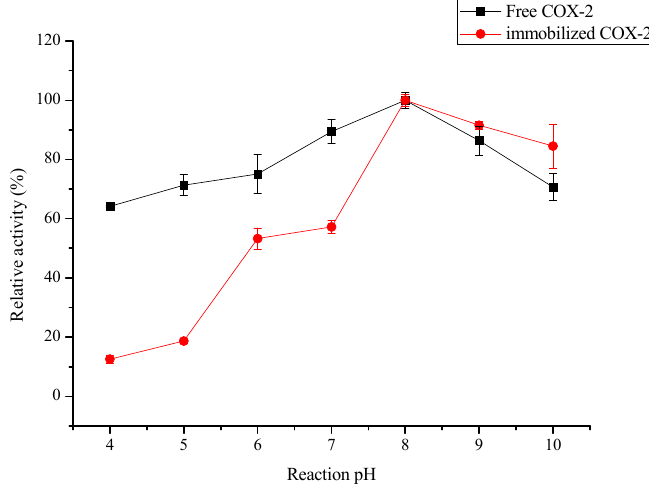
Figure 5. Effect of reaction pH on the biocatalytic activity of the immobilized COX-2 and free COX-2 ( n = 3).